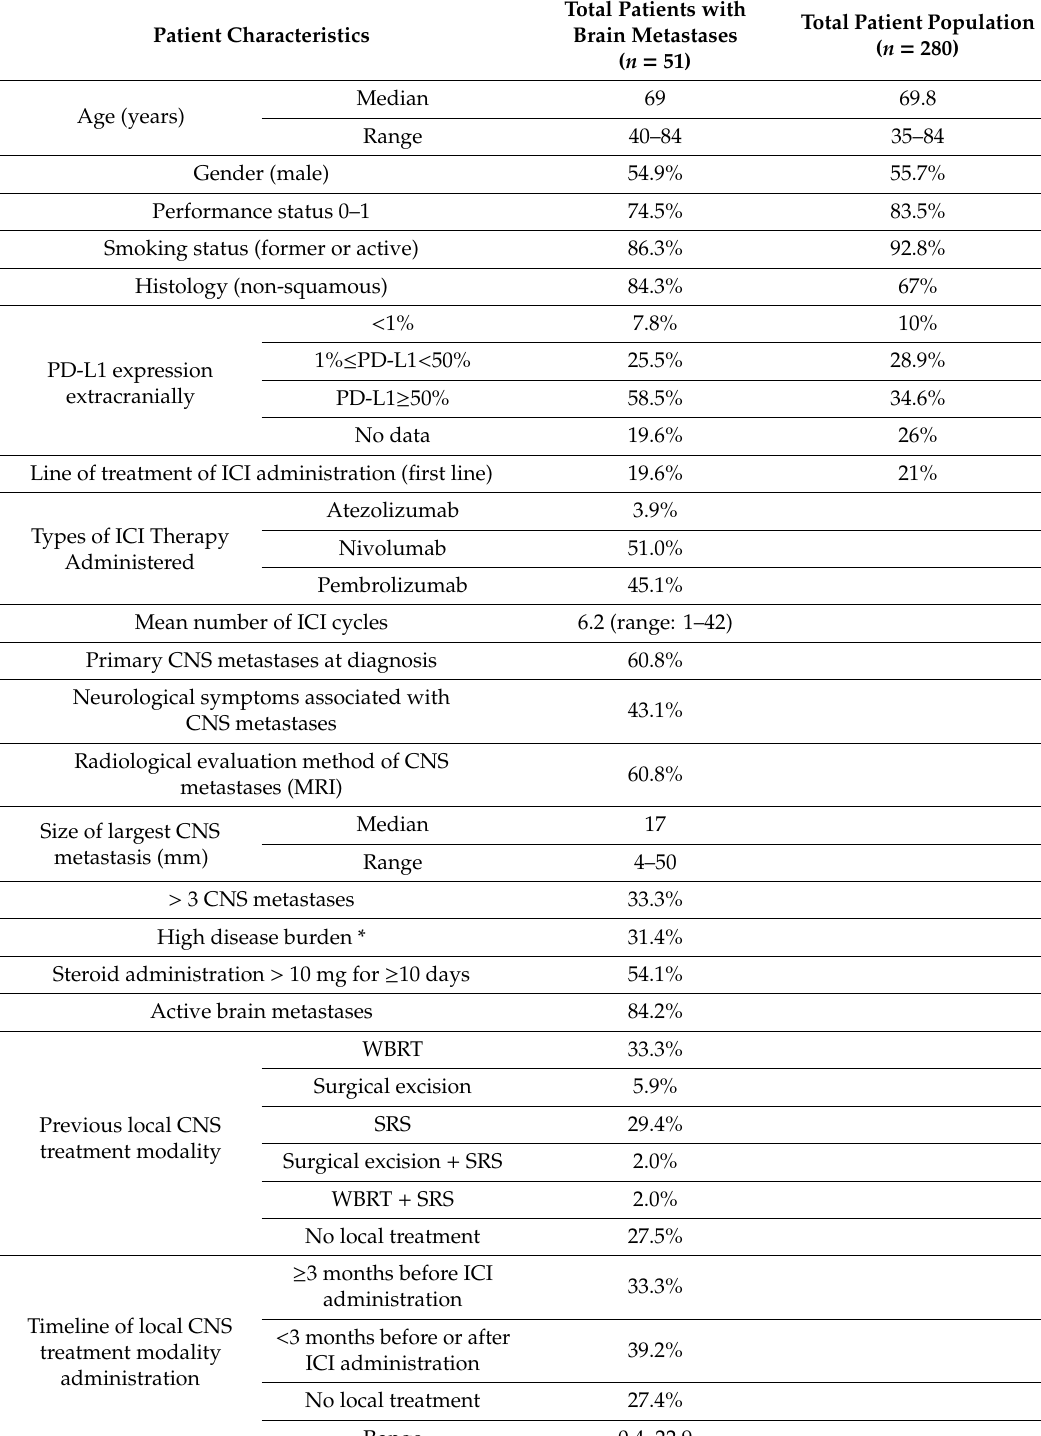
Table 1. Patient